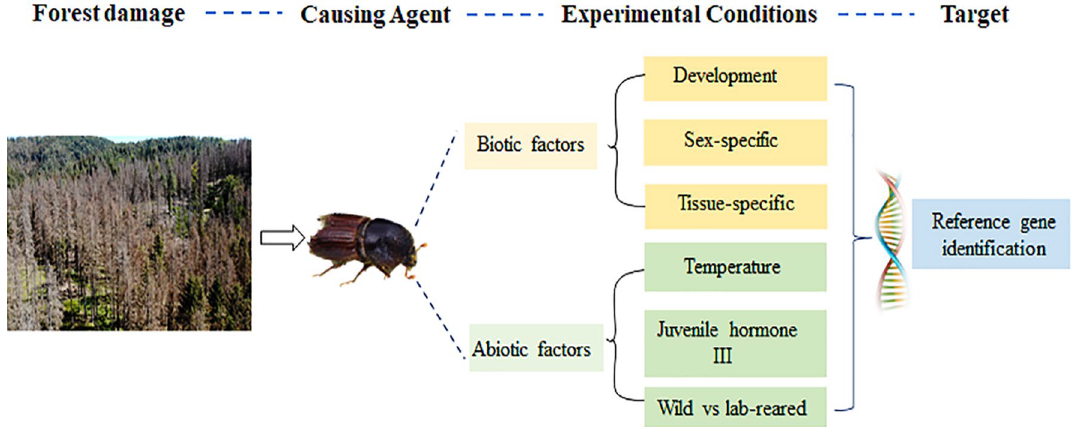
Figure 1. Schematic representation of experimental plan for finding reference genes in Ips typographus .